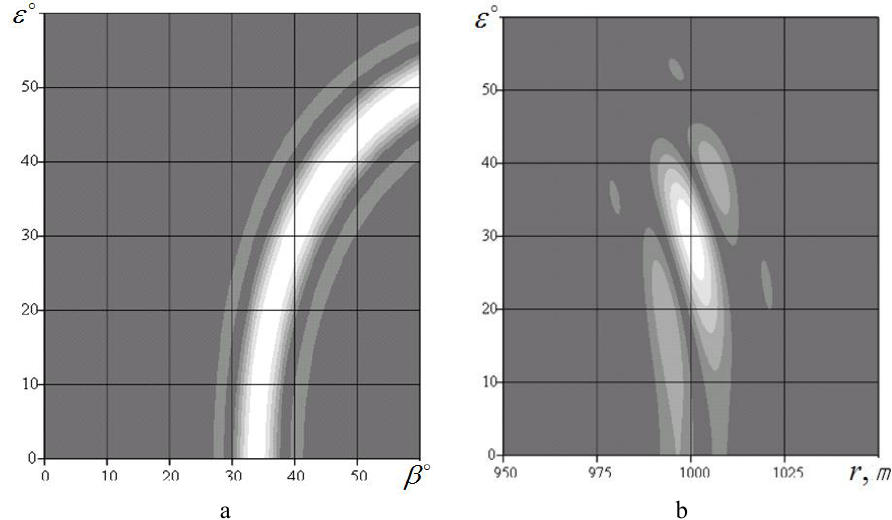
Fig. 4. Two-dimensional generalized ambiguity function cross- sections. «Azimuth — elevation» cross- section is shown in (a) and «range — elevation» cross -section is shown in (b) for (I) coordinate system type and target coordinates